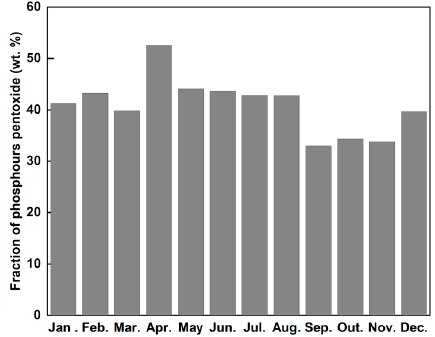
Figure 2. Monthly fraction of phosphate in the sewage sludge ash.